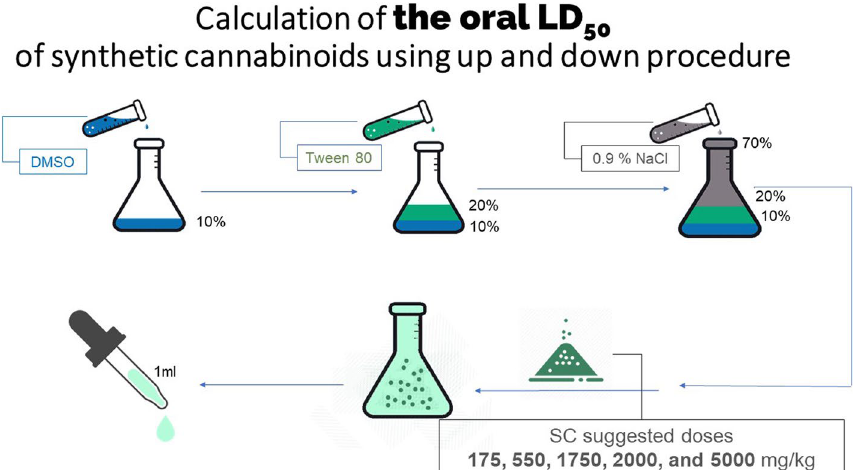
Fig. 1 Calculation of oral LD50 of synthetic cannabinoids (Strox) using up-and-down-procedure